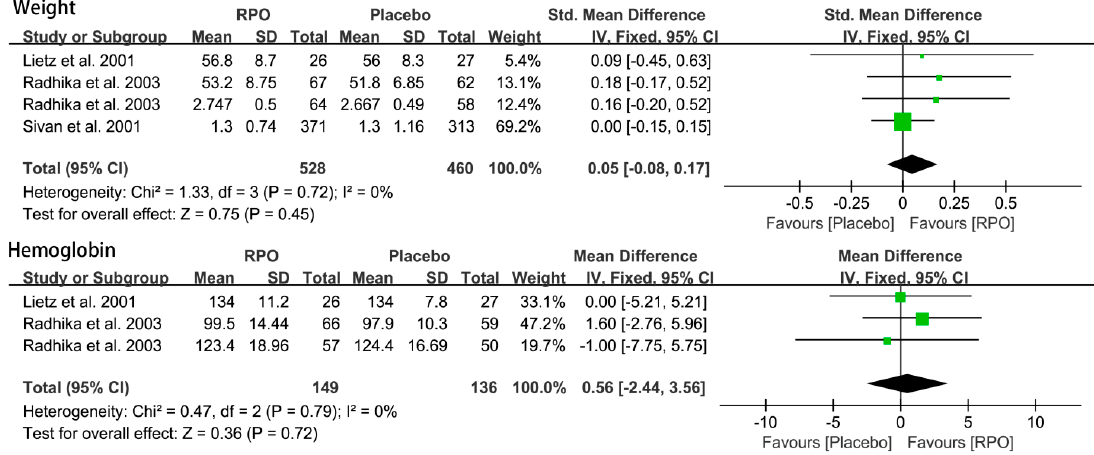
Figure 7. Forest plots of the effect of red palm oil (RPO) intervention on body weight and hemoglobin (g/L) for the RPO group vs. placebo group. CI: confidence interval.